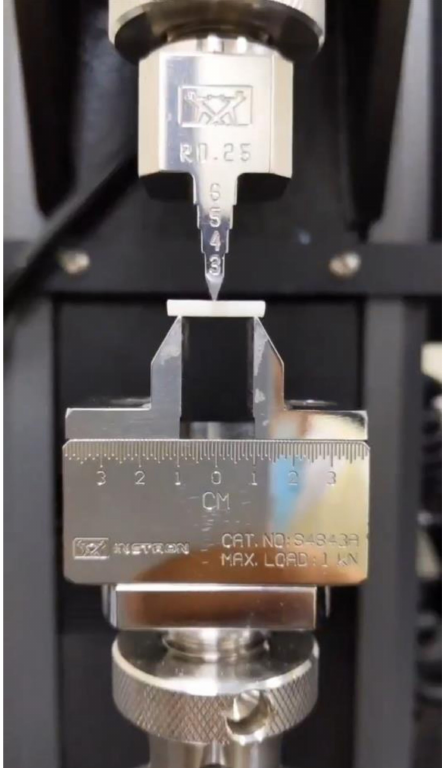
Figure 1. Specimen seated on universal testing machine for testing flexural